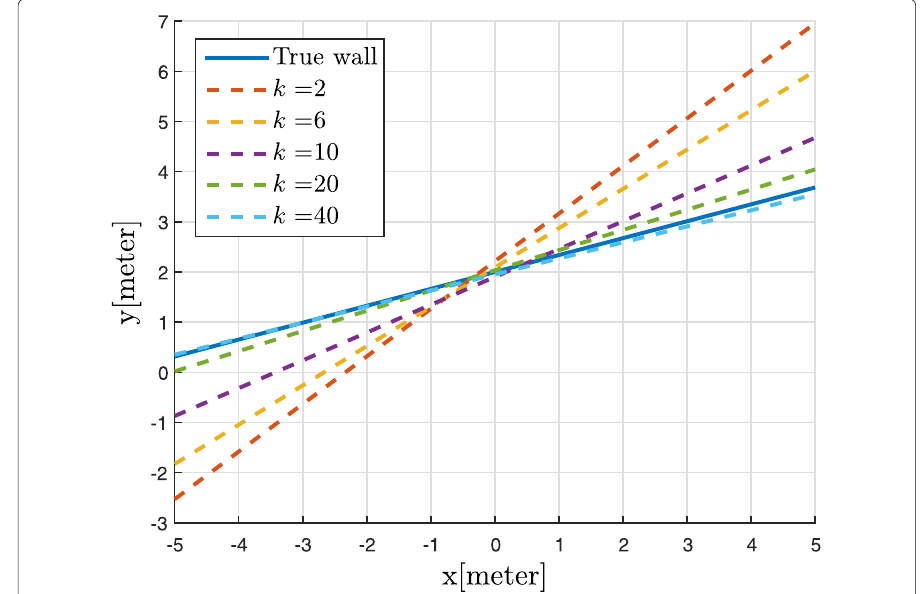
Fig. 6 Wall line reconstruction is presented using y = tan ( ˆ α k ) x + ˆ b k , where the wall angle ˆ α k and the wall offset ˆ b k are the estimated values obtained from the EKF algorithm presented in Section 4. The estimated wall line is drawn for different robot steps k =